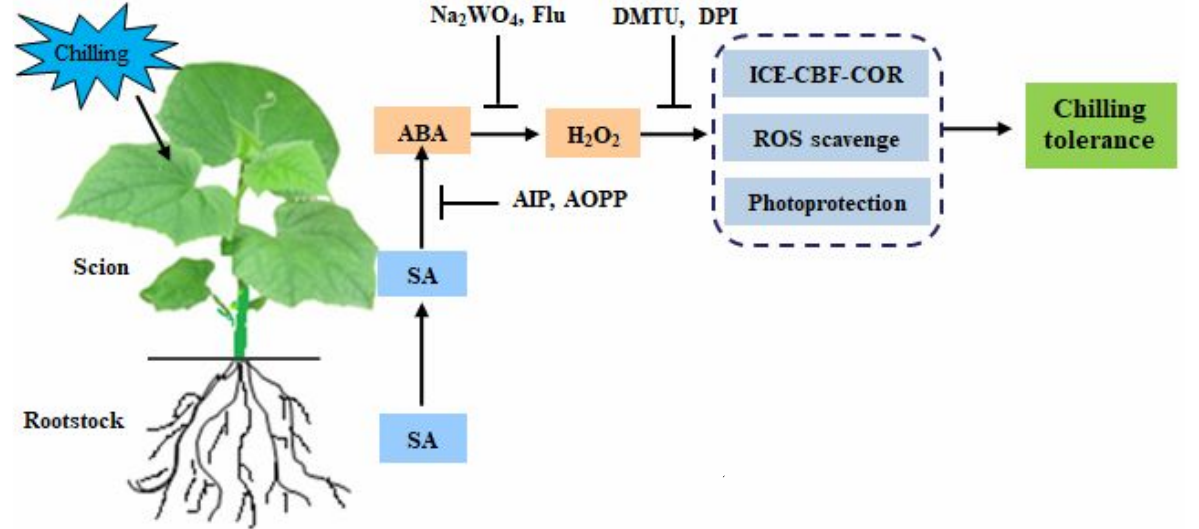
Figure 10. A model of SA-induced ABA and subsequent H 2 O 2 accumulation in grafted cucumbers in response to chilling stress.